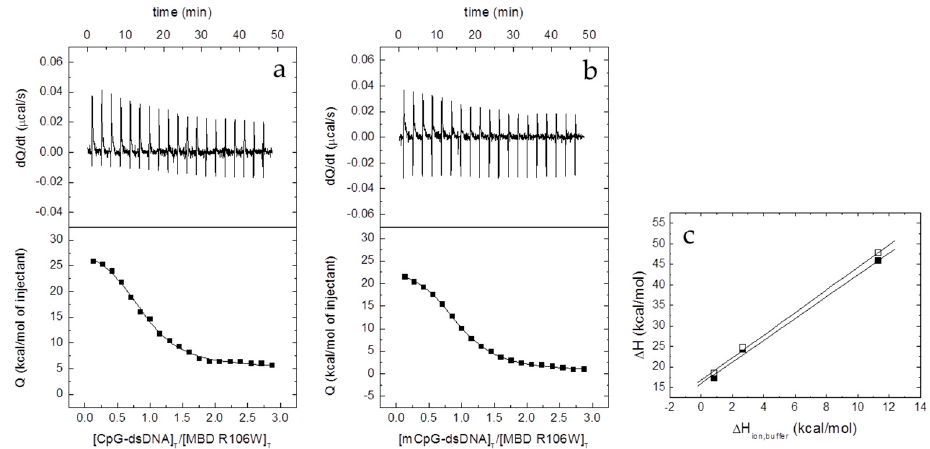
Figure 4. Interaction of the MBD R106W with unmethylated CpG-dsDNA ( a ) and methylated mCpG-dsDNA ( b ) by ITC in Pipes 50 mM, pH 7, 20 ◦ C. Upper plots show the thermogram (raw thermal power as a function of time) and the lower plots show the binding isotherm (ligand-normalized heat e ff ects as a function of the molar ratio). Non-linear least-squares analysis using a single binding site model allowed estimating the observed binding a ffi nity and enthalpy (continuous lines). ( c ) Equation (2) was employed for estimating the bu ff er-independent binding enthalpy: CpG-dsNA (open squares) and mCpG-dsDNA (closed squares). From linear regression, the intercept with the y -axis (observed